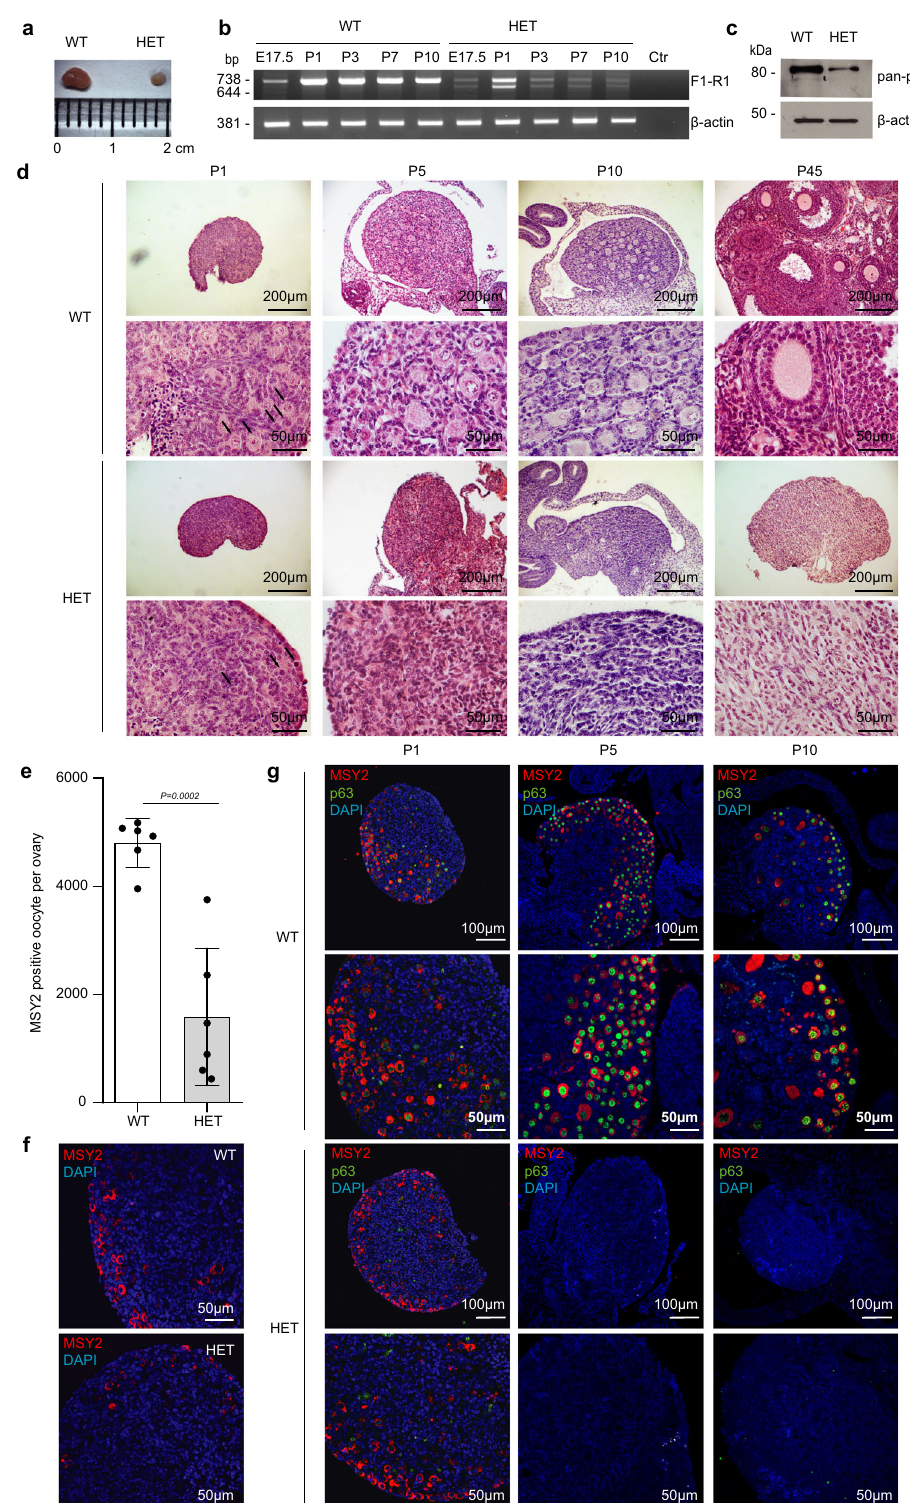
characterization by H/E staining of P1, P5, P10, and P45 ovaries revealed that, while WT and HET Δ 13p63 P1 ovaries showed similar morphologies with the presence of primordial follicles (Fig. 2d, arrows), HET Δ 13p63 P5 and P10 ovaries presented an atretic morphology and almost total absence of follicles, aspects even more evident in HET Δ 13p63 P45 ovaries (Fig. 2d). More- over, HET Δ 13p63 P1 ovaries showed signi fi cant less (40%)